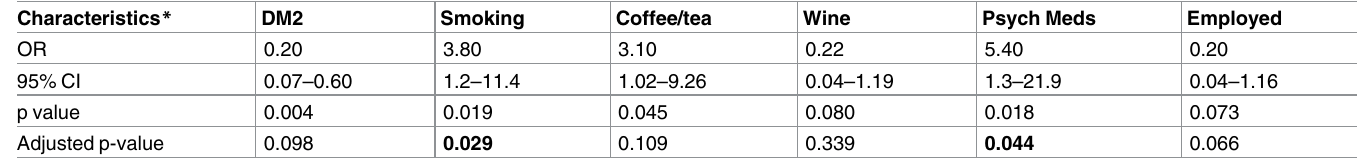
Table 2. Odds ratio (OR) for the highest vs. the lowest (reference) oxytocin level tertiles in male veterans. Characteristics